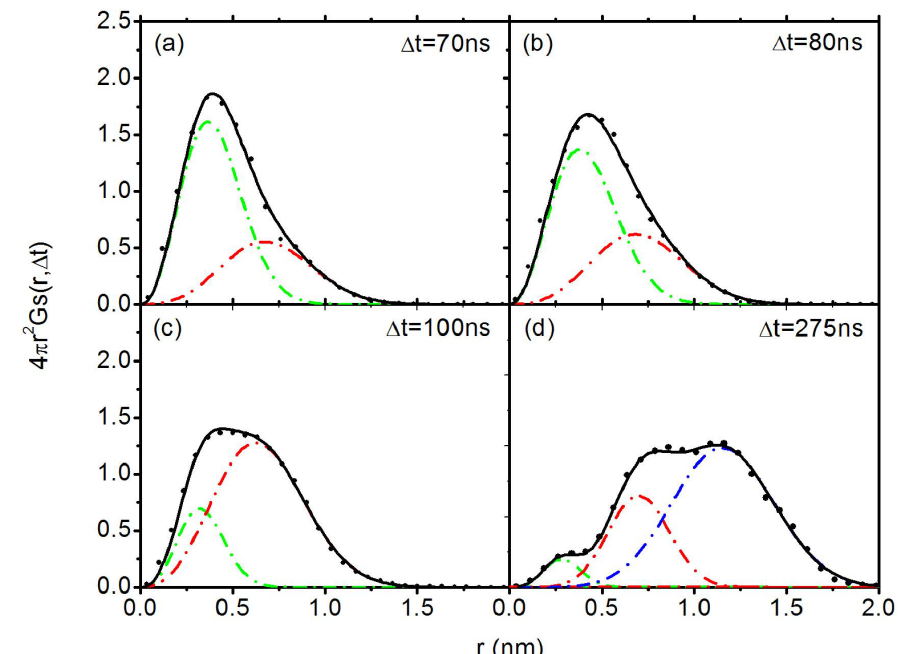
Figure 8. The DDF, 4 π r 2 G s ( r , ∆ t ) , for C 60 in PS melt at different time scales (symbols). The dash dot lines are multiple Gaussian fittings, their sum is represented by the black solid